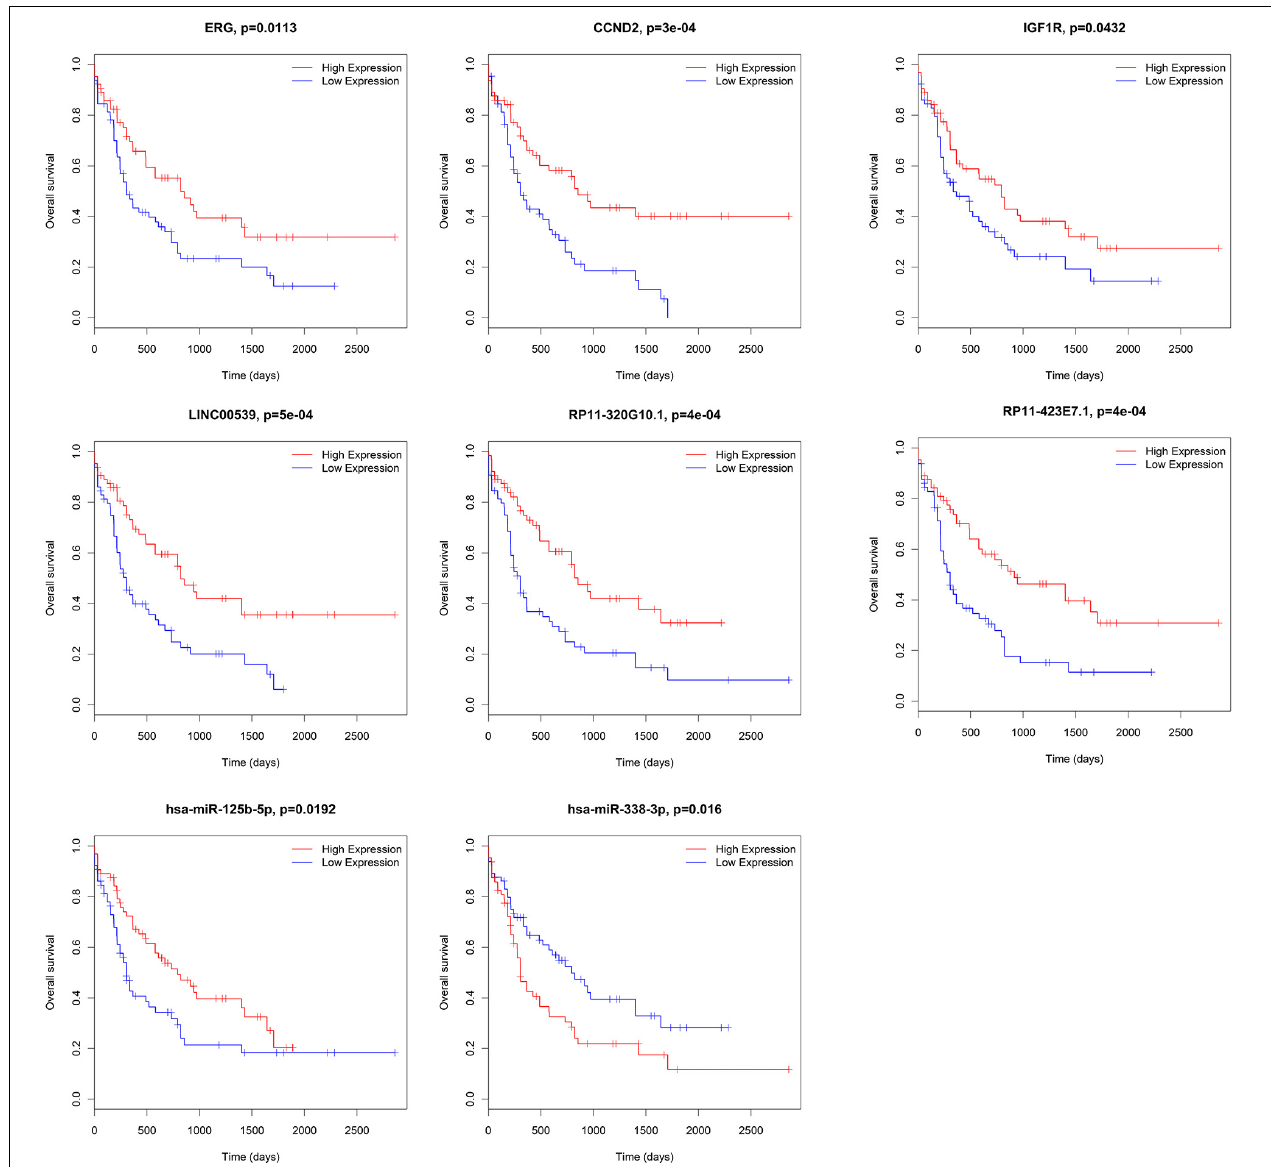
FIGURE 7 | Correlation between mRNAs, miRNAs and lncRNAs in ceRNA and overall AML survival in TCGA. Kaplan–Meier survival curves with the log-rank test were performed for the representative mRNAs, miRNAs and lncRNAs. ceRNA, competing endogenous RNAs; AML, acute myeloid leukemia; TCGA: The Cancer Genome